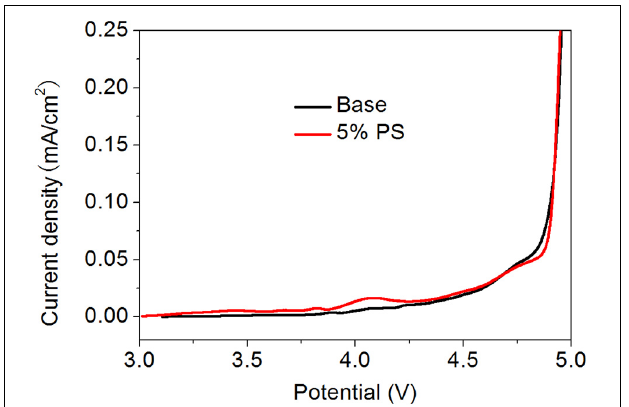
FIGURE 4 | LSV of Pt electrode in 1.0 M LiPF 6 -EC / EMC (1:2) with and without 5% PS. The area of working electrode was 1.0 cm 2 .